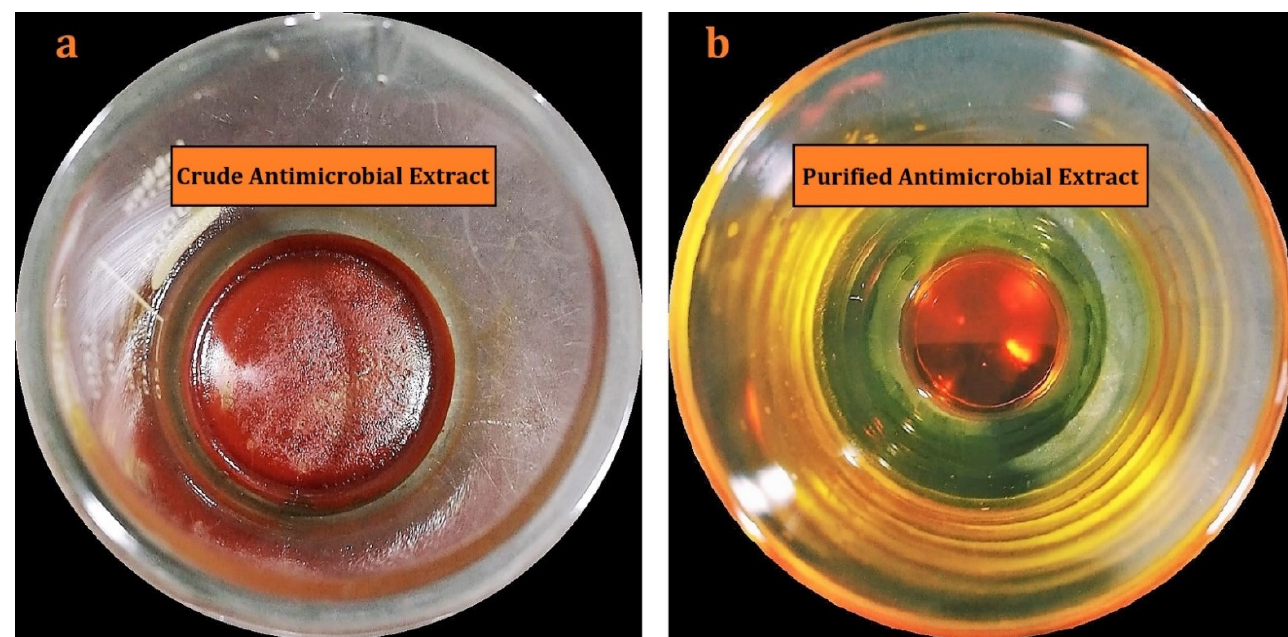
Figure 2. Antimicrobial extracts: ( a ) crude antimicrobial extract ( b ) purified antimicrobial extract.